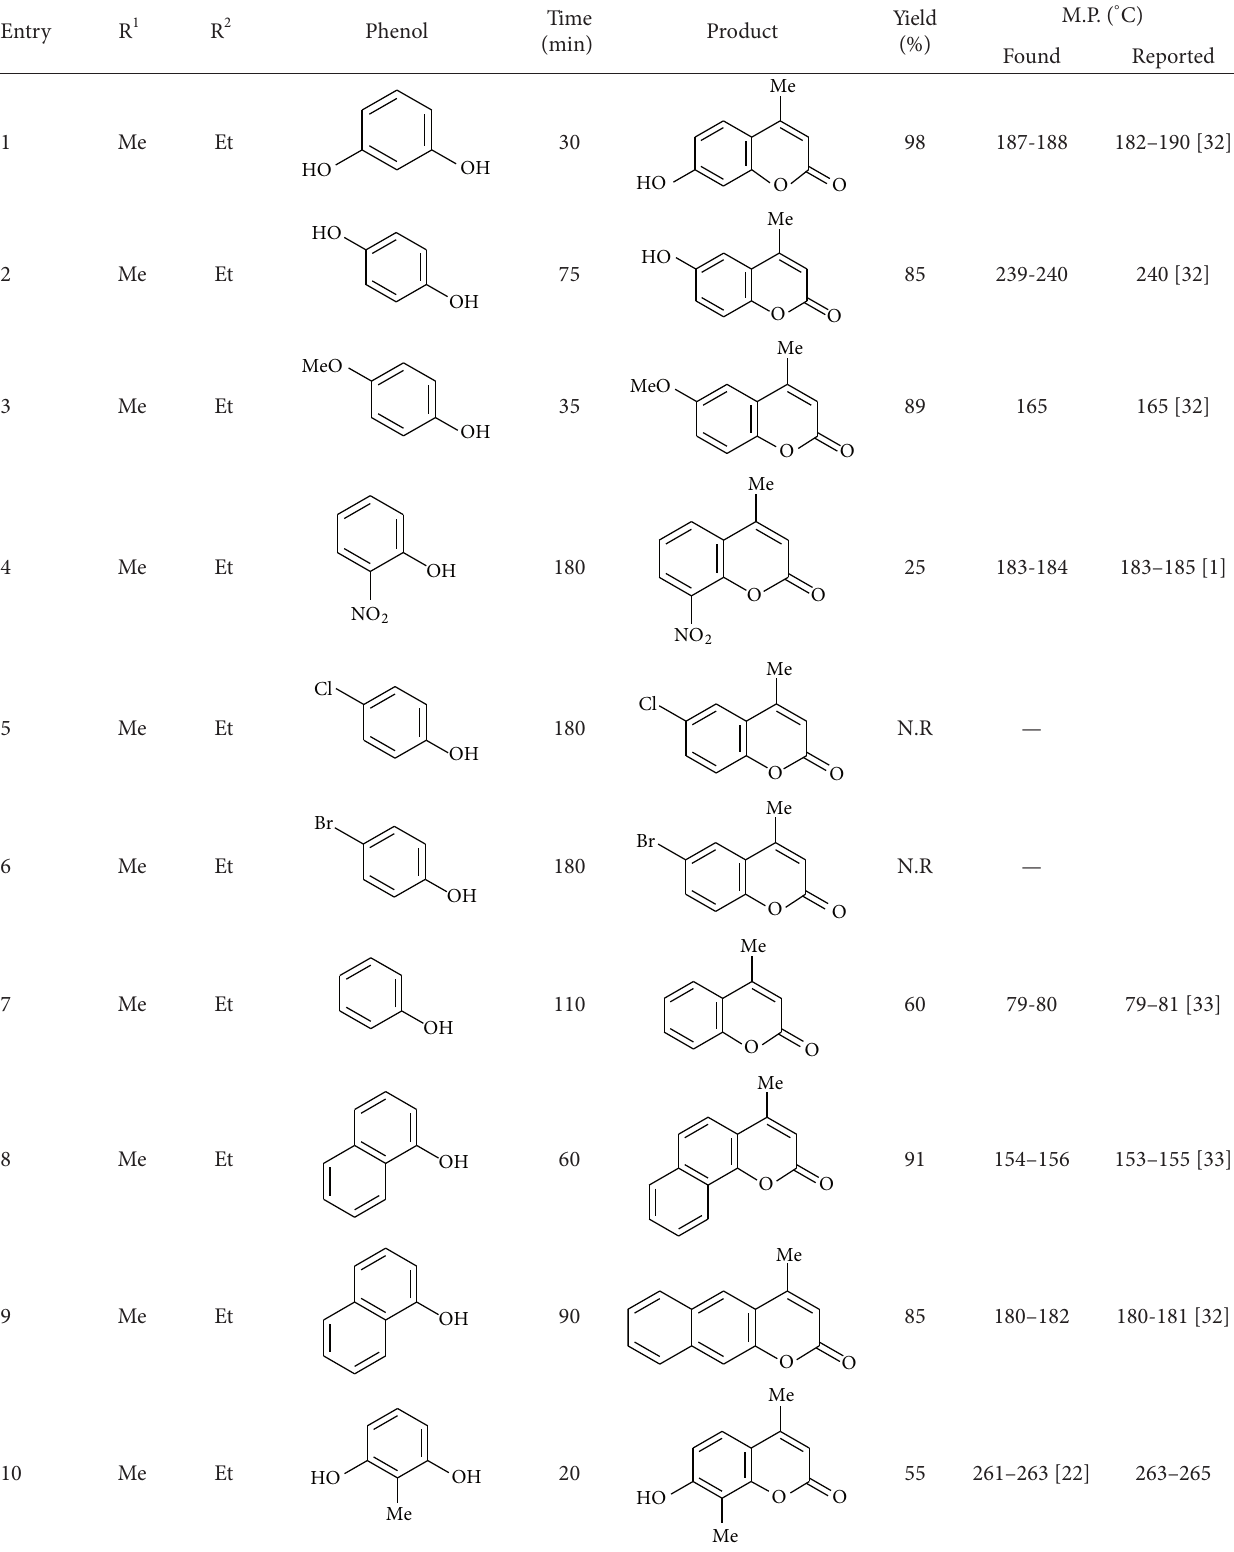
T 4: Preparation of different coumarins catalyzed by ASA (0.02g) in solvent-free conditions at